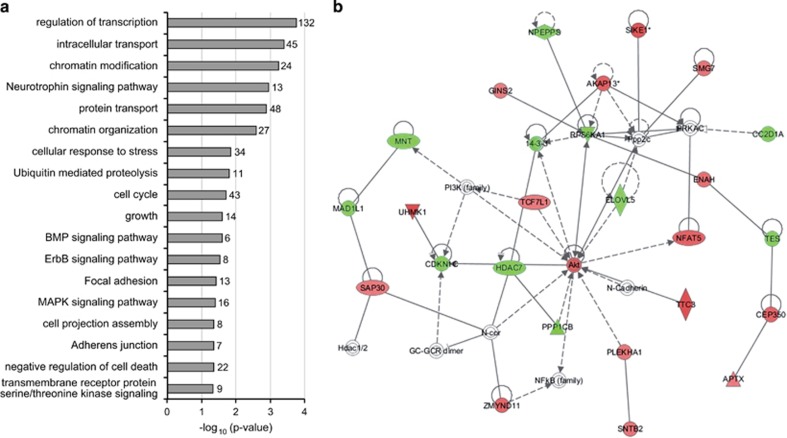
Gene expression changes caused by exposure to 5 μM cocaine in vitro after 6 h. (a) Representative over-represented biological categories (Gene Ontology terms, GO) and pathways (Kyoto Encyclopedia of Genes and Genomes, KEGG) identified by DAVID software among the differentially expressed genes. The number of genes with altered expression included in each category is indicated on the right side of the bar. (b) Gene network involved in molecular transport, cell-to-cell signaling and interaction and cellular development (score=34). The green and red nodes in the pathway indicate the down- and upregulated genes, respectively, induced by 5 μM cocaine–HCl after 6 h.